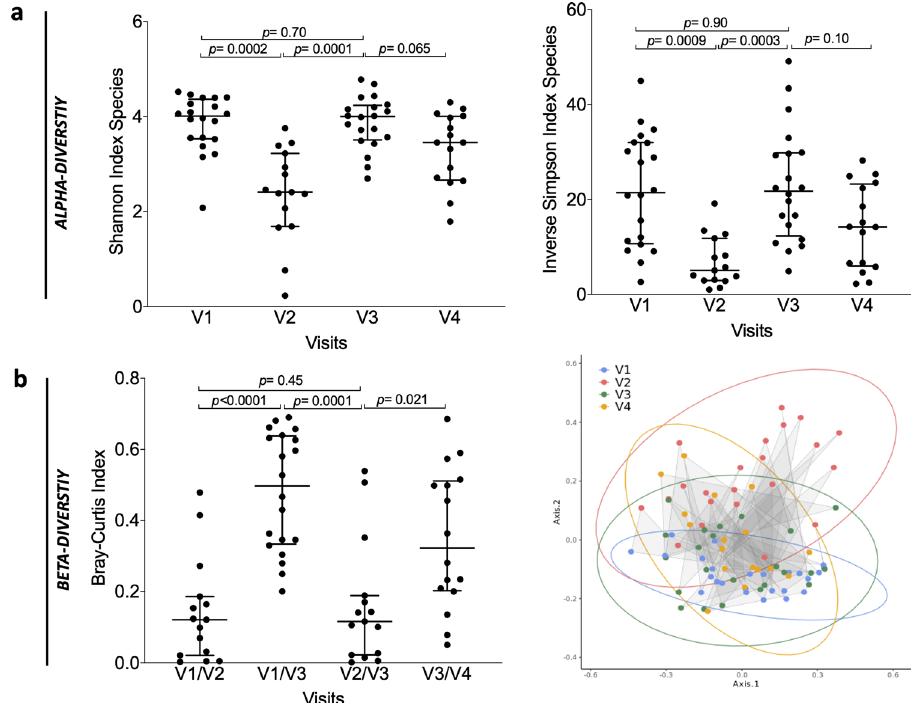
Fig. 2 Characterization of the fecal microbiota from visit 1 (V1) to visit 4 (V4) in per-protocol patients ( n = 20). a Alpha-diversity measured at species level with, from left to right: Shannon and Inverse Simpson indexes ( P -value were determined by two-sided signed-rank Wilcoxon paired test, no adjustments were made for multiple comparisons, error bars indicate median and interquartile range). b Beta-diversity measured at species level with the Bray – Curtis index comparison between visits and Principal Coordinates Analysis based on Bray – Curtis similarity at each visit ( P -value were determined by two-sided signed-rank Wilcoxon paired test, no adjustments were made for multiple comparisons, error bars indicate median and interquartile range). Source data are provided as a Source Data fi le.